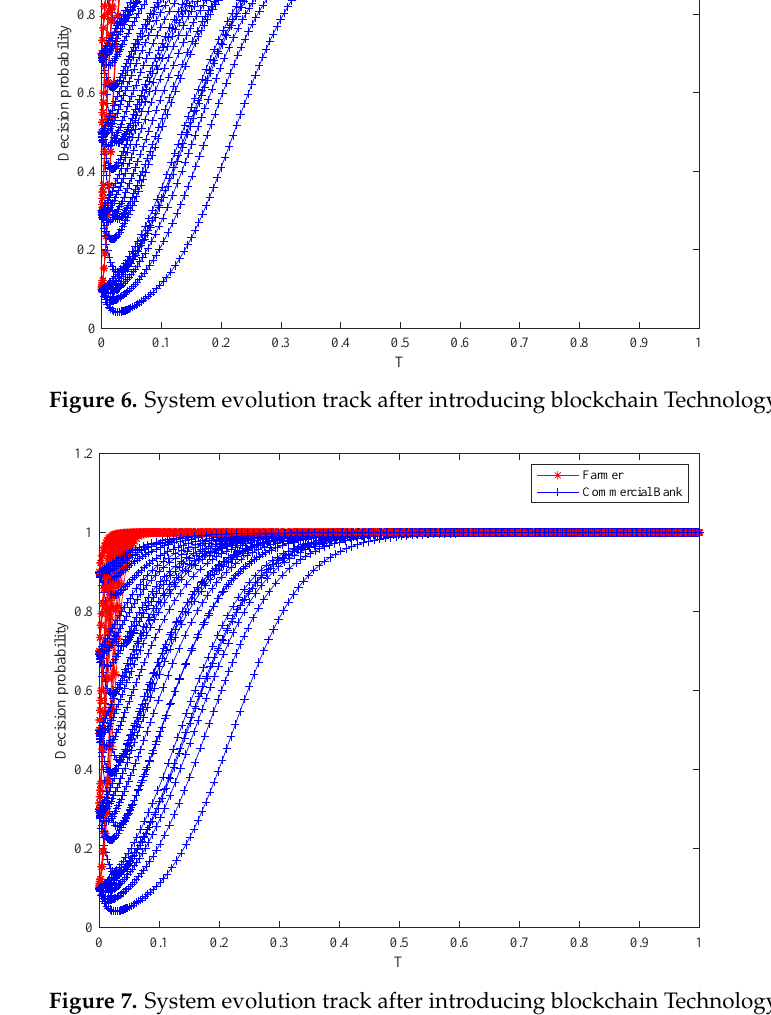
Figure 7. System evolution track after introducing blockchain Technology ( P =